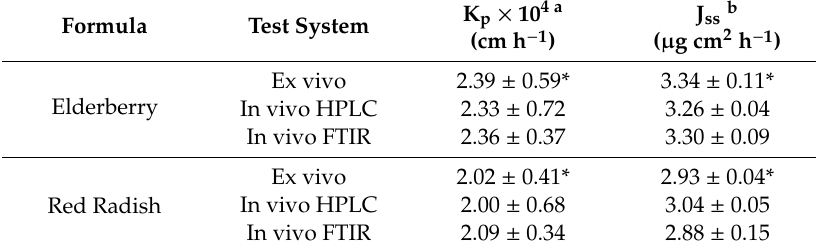
Table 4. Estimated permeability coe ffi cients (Kp) and steady state fluxes (Jss) of anthocyanins across the SC following lipstick application either in vivo in human volunteers or ex vivo on porcine ear skin (mean ± standard deviation, n = 9). Statistical significance denoted by (*) ( p ≤ 0.05), determined by two-way